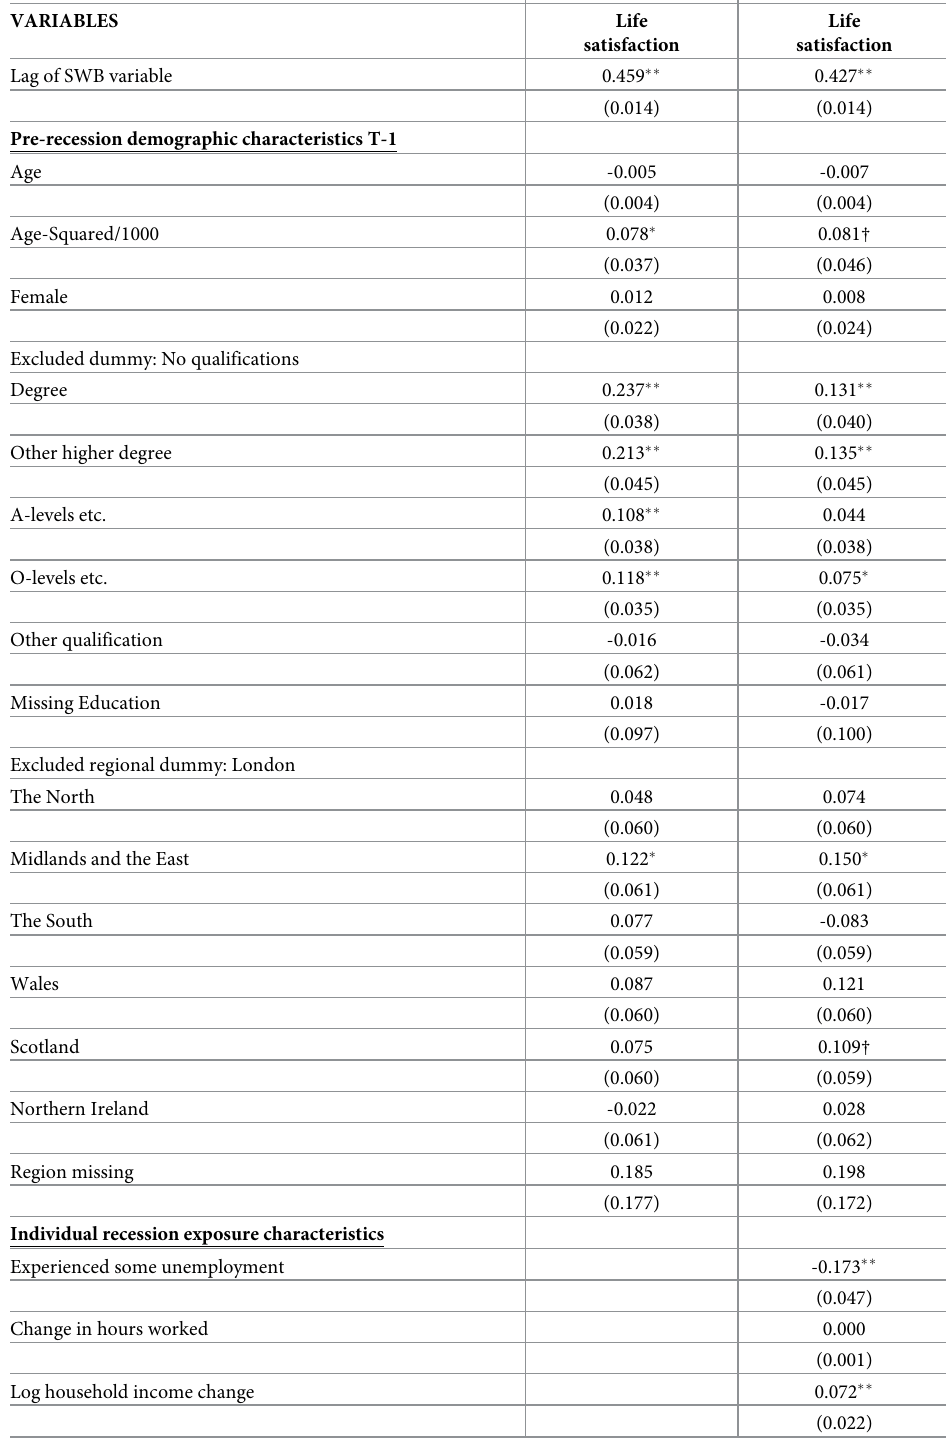
Table 3. Subjective well-being changes from 2006/7 to 2009/2010 (individual recession exposure characteristics, pre-recession demographic and socio-economic variables): Differences relative to an uneducated average aged man, living in in London, and who remained